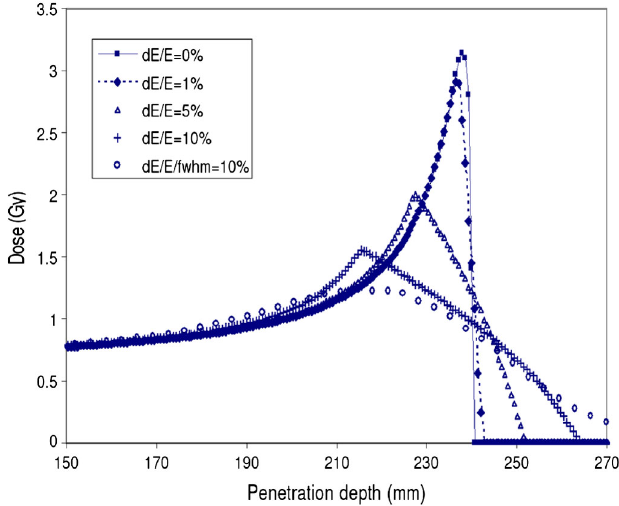
FIG. 2. Depth dose profiles for protons in water with initial fluences 10 9 = cm 2 and different incoming energy widths ( 0 . . . (cid:2) 10%